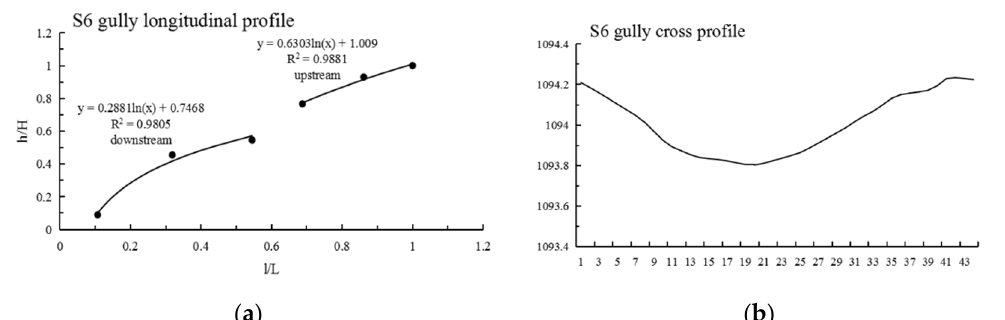
Figure 7. Longitudinal and cross profile fitting diagram of S6.